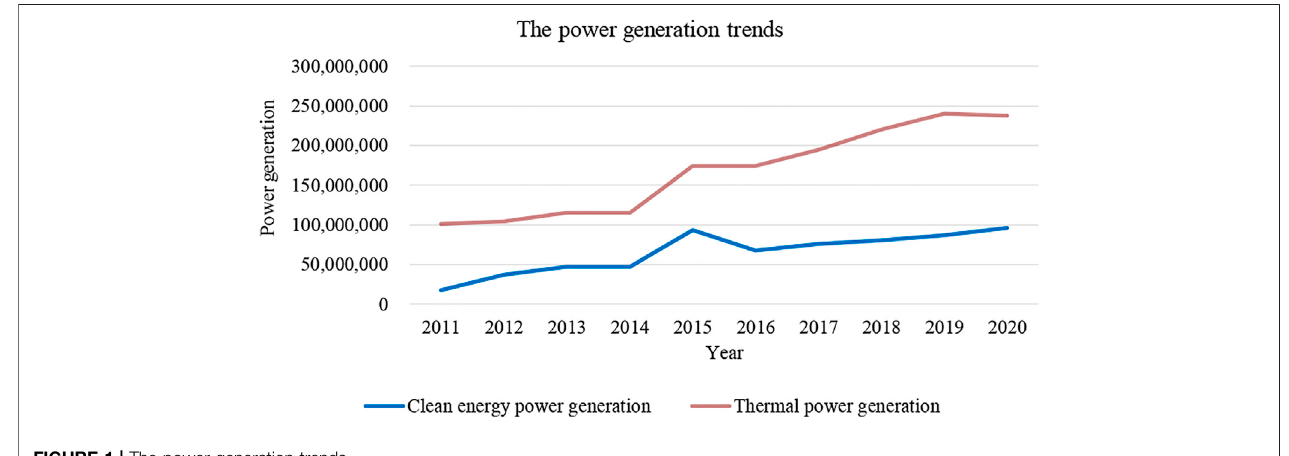
FIGURE 1 | The power generation trends.